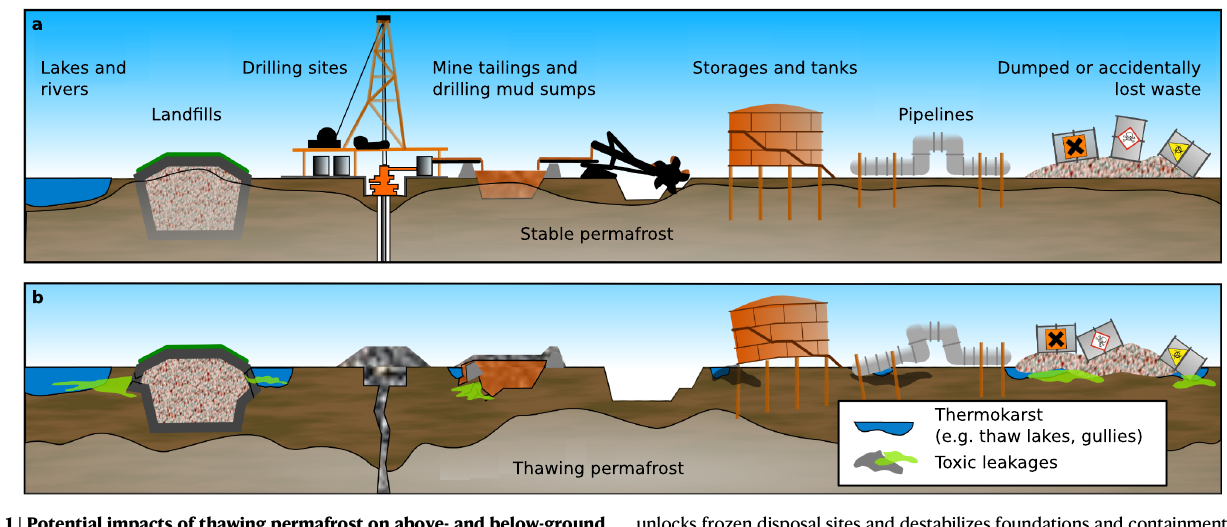
unlocks frozen disposal sites and destabilizes foundations and containment structures b . Furthermore, permafrost thaw intensi fi es thermo-hydrological ero- sion and increases the lateral fl ow of water, fostering the dispersion of